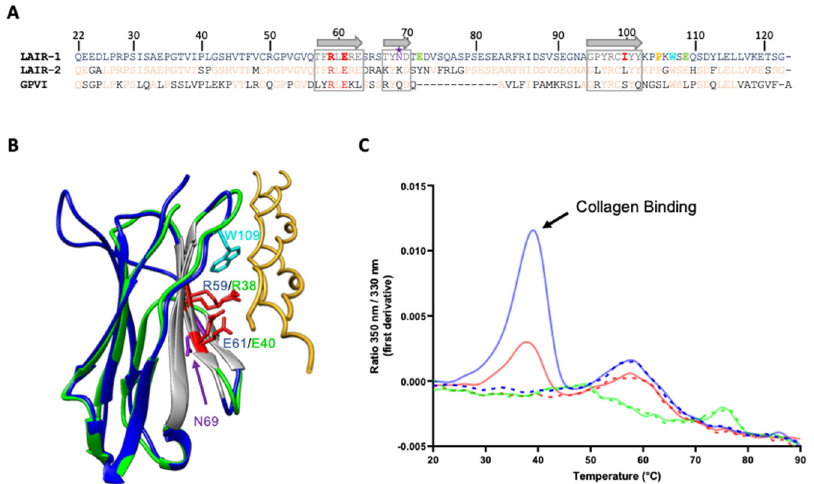
Figure 5. LAIR-1 R59 and E61 are central collagen binding residues, conserved in LAIR-2 and GPVI. ( A ) Sequence alignment of LAIR-1, LAIR-2 and GPVI Ig-like domains. The β -strands forming the collagen interaction groove in LAIR-1 are indicated with grey arrows and the N-glycosylation site (N69) is indicated with a purple star. The LAIR-1 mutated residues are colored in red for the central collagen binding site and in green and orange for the identified distal residues. LAIR-1 conserved and different residues in LAIR-2 and GPVI sequences are colored in light orange and black, respectively. ( B ) Alignment of the crystal structure of the Ig-like domains of LAIR-1 (in blue, PDB code: 3KGR) and GPVI (in green) in complex with a collagen peptide (in yellow) (PDB code: 5OU8). LAIR-1 R59 and E61 and the GPVI homologous residues are colored in red. LAIR-1 N69 is labeled in purple. The remarkable W109 in LAIR-1, close to the collagen ligand, is labeled in cyan. ( C ) NanoDSF experiments of LAIR-1 WT (in blue), R59A (in green) and E61A (in red), alone (dashed lines) or in the presence of a positive collagen peptide control (solid lines).